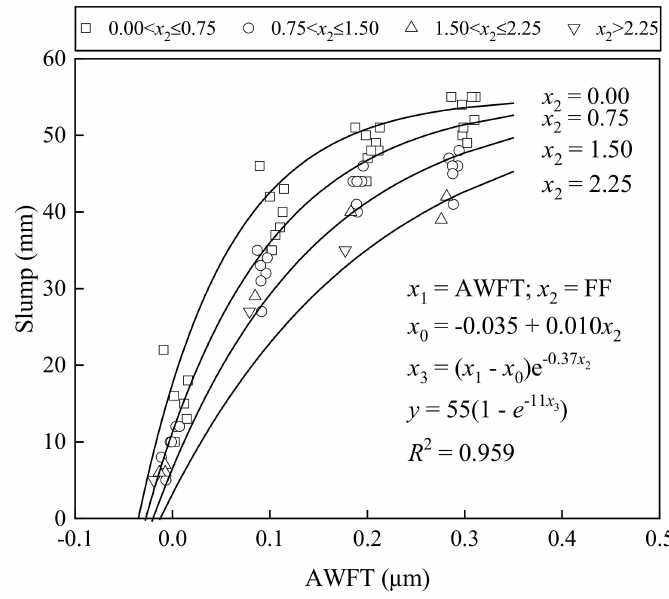
Figure 5. Correlation of slump with AWFT and FF.